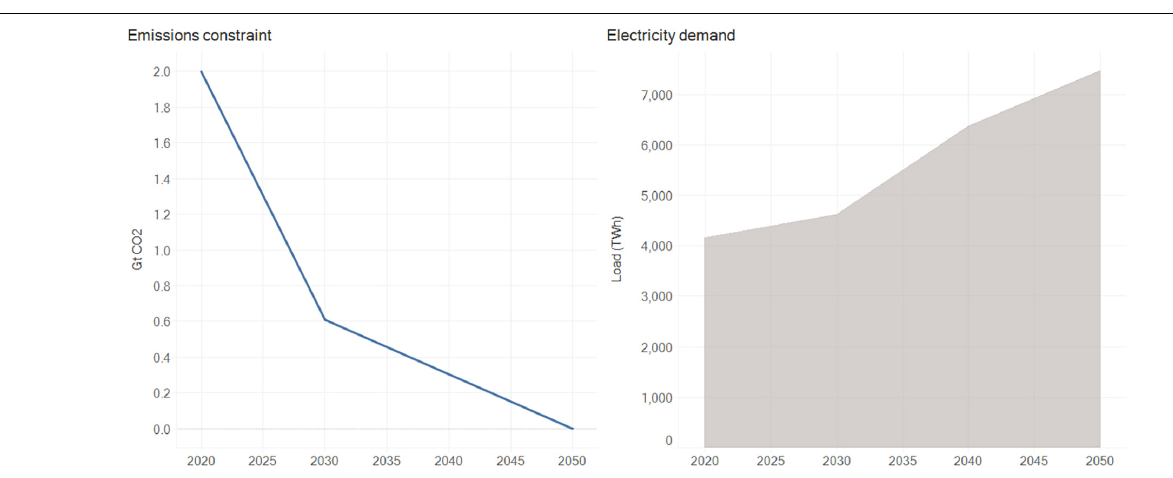
FIGURE 2 | Left: United States emissions constraint. Right: Electricity load